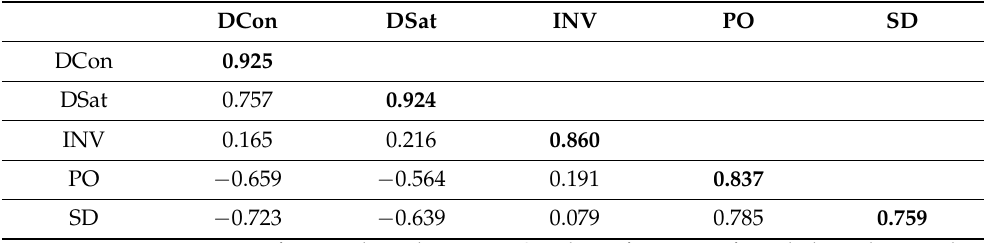
Table 4. Results of correlation